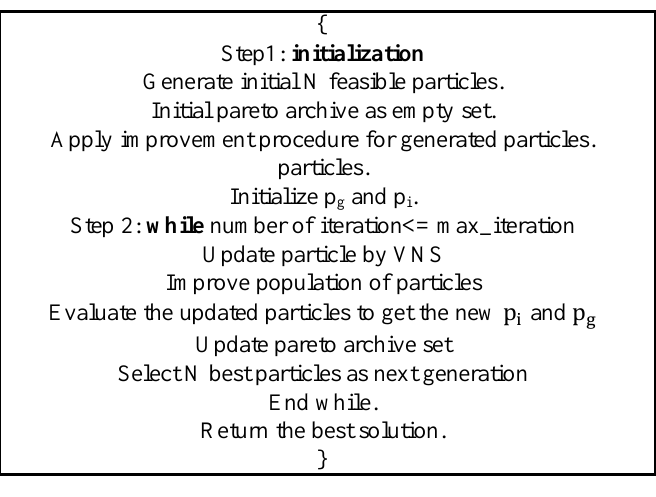
Figure 1. Outline of particles swarm